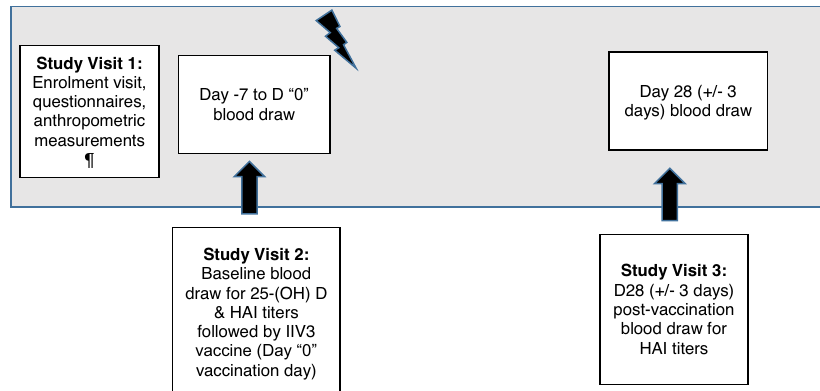
Fig. 3 Outline of study visits, the DYNAMIC cohort study. ¶ anthropometric measurements comprised weight (kg), height (m), waist, and hip circumferences (cm). BMI (kg/m 2 ), and waist: hip circumference ratios were